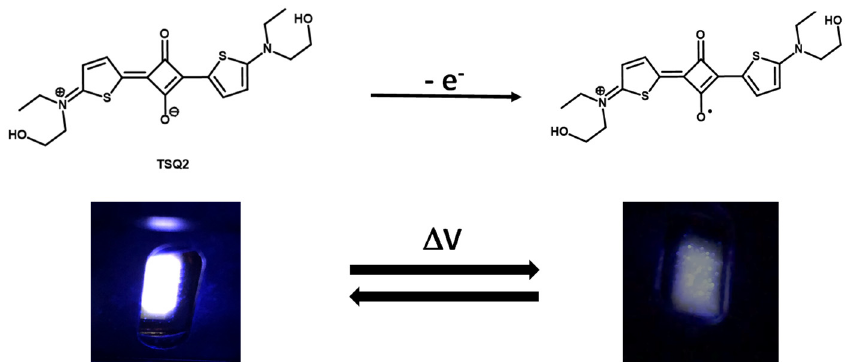
Figure 3. Electrochemical oxidation of the thienosquaraine TSQ2 in the device: the white fluorescence of the zwitterionic species is quenched by the application of a potential difference that generate the low-emissive radical cation species.